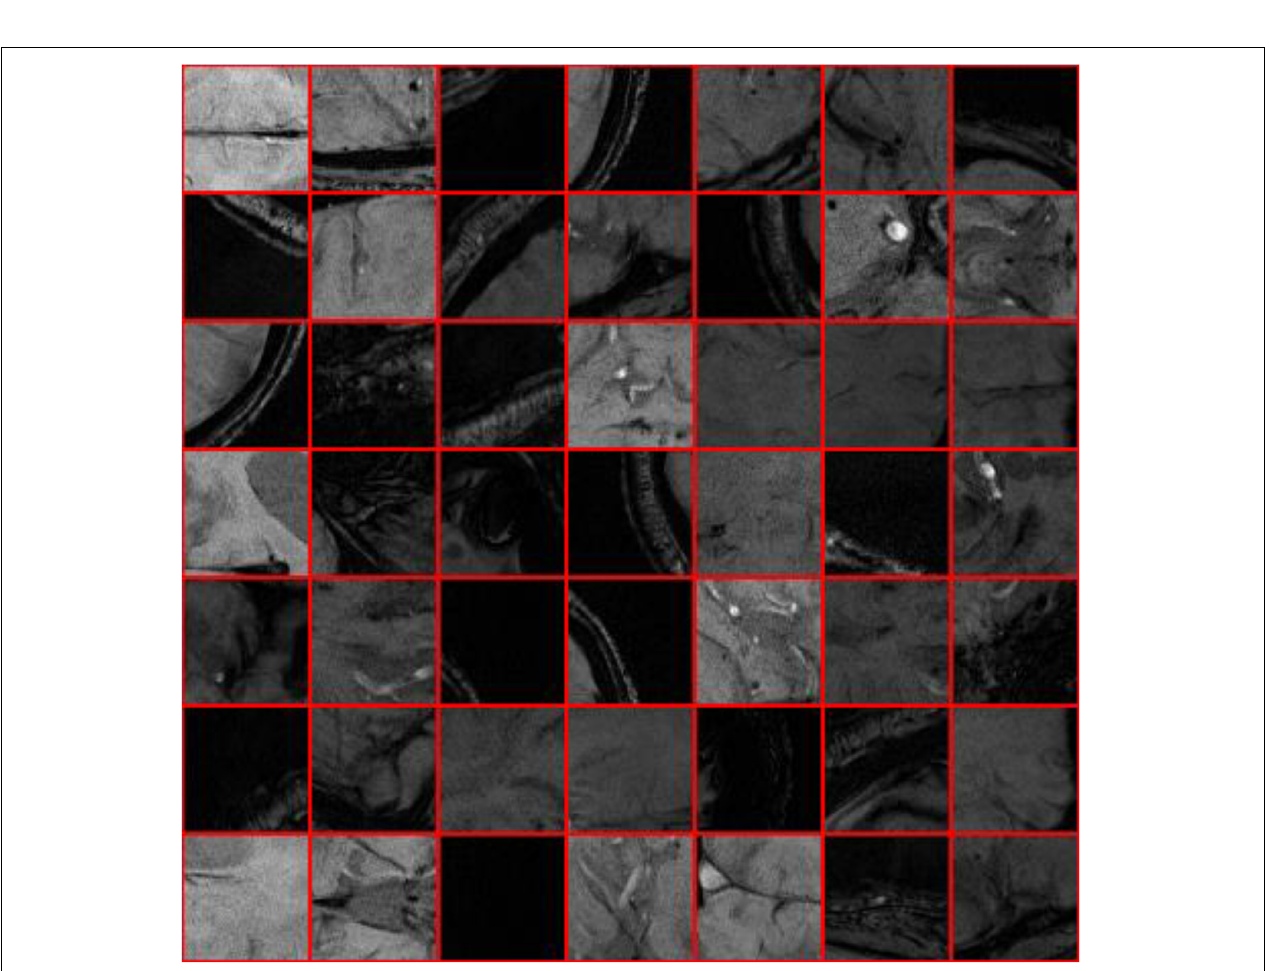
FIGURE 4 | Non-CMB